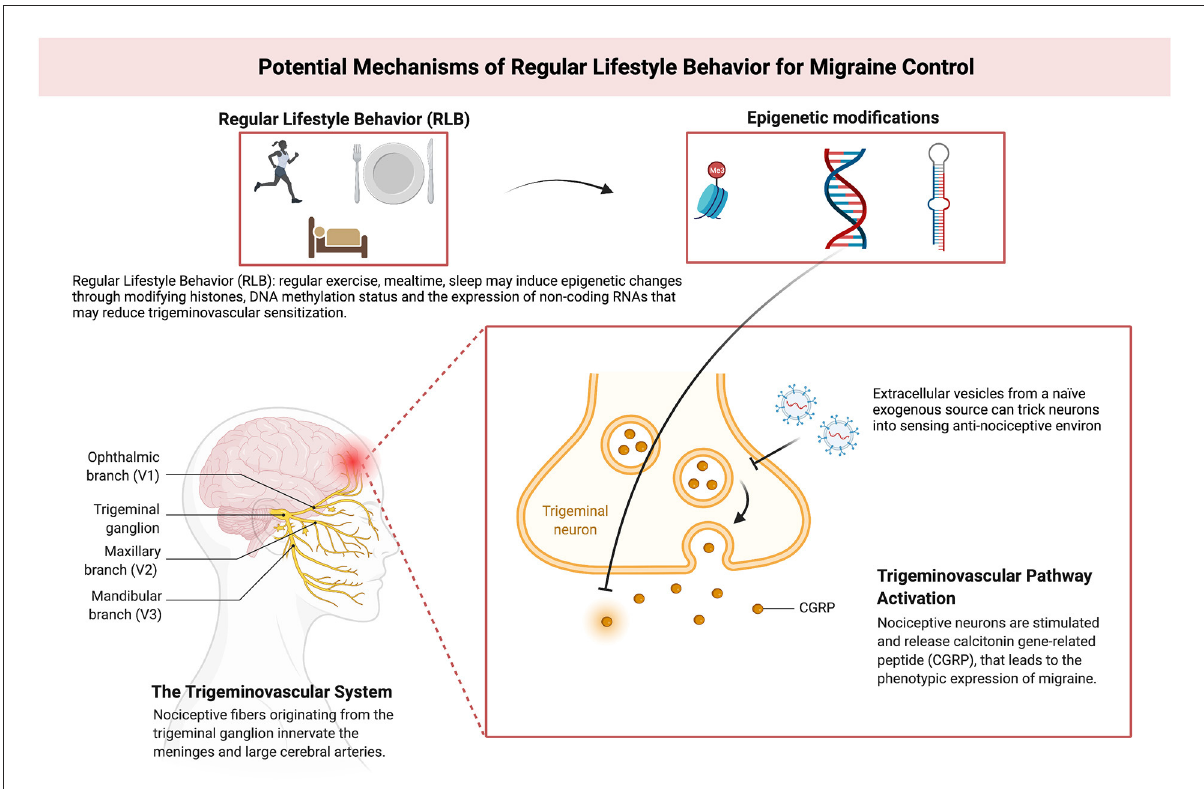
FIGURE1 Model depicting putative mechanisms of Regular Lifestyle Behavior (RLB) for migraine control. Adapted from “The role of CGRP and the trigeminal system in migraine pathophysiology”, by BioRender.com (2022). Retrieved from